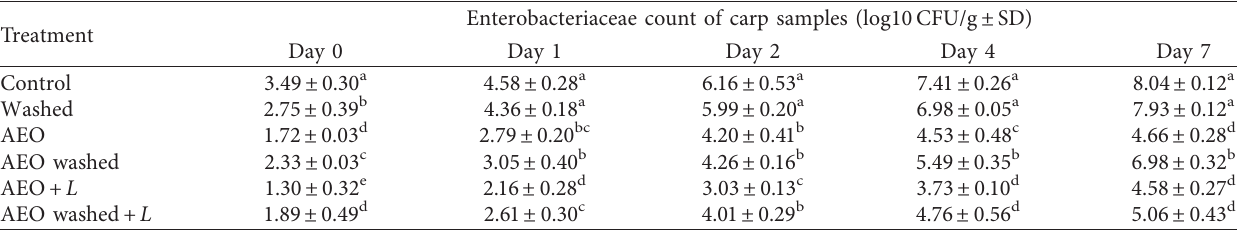
Table 3: Effects of washing, acidic electrolyzed oxidizing water, and lysozyme treatments on the Enterobacteriaceae count of carp samples.